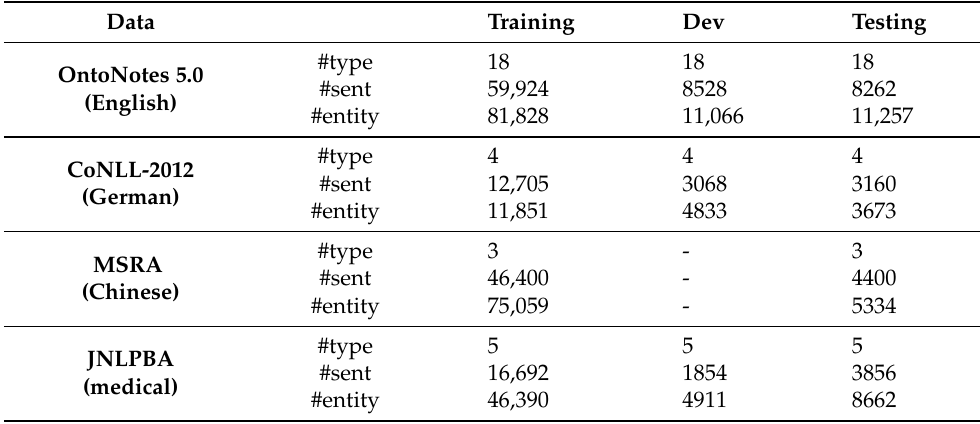
Table 1. Statistics of the datasets, where #type denotes the number of types, #sent denotes the number of sentences and #entity denotes the number of entities. Data Training Dev Testing #type 18 18 18 OntoNotes 5.0 (English)